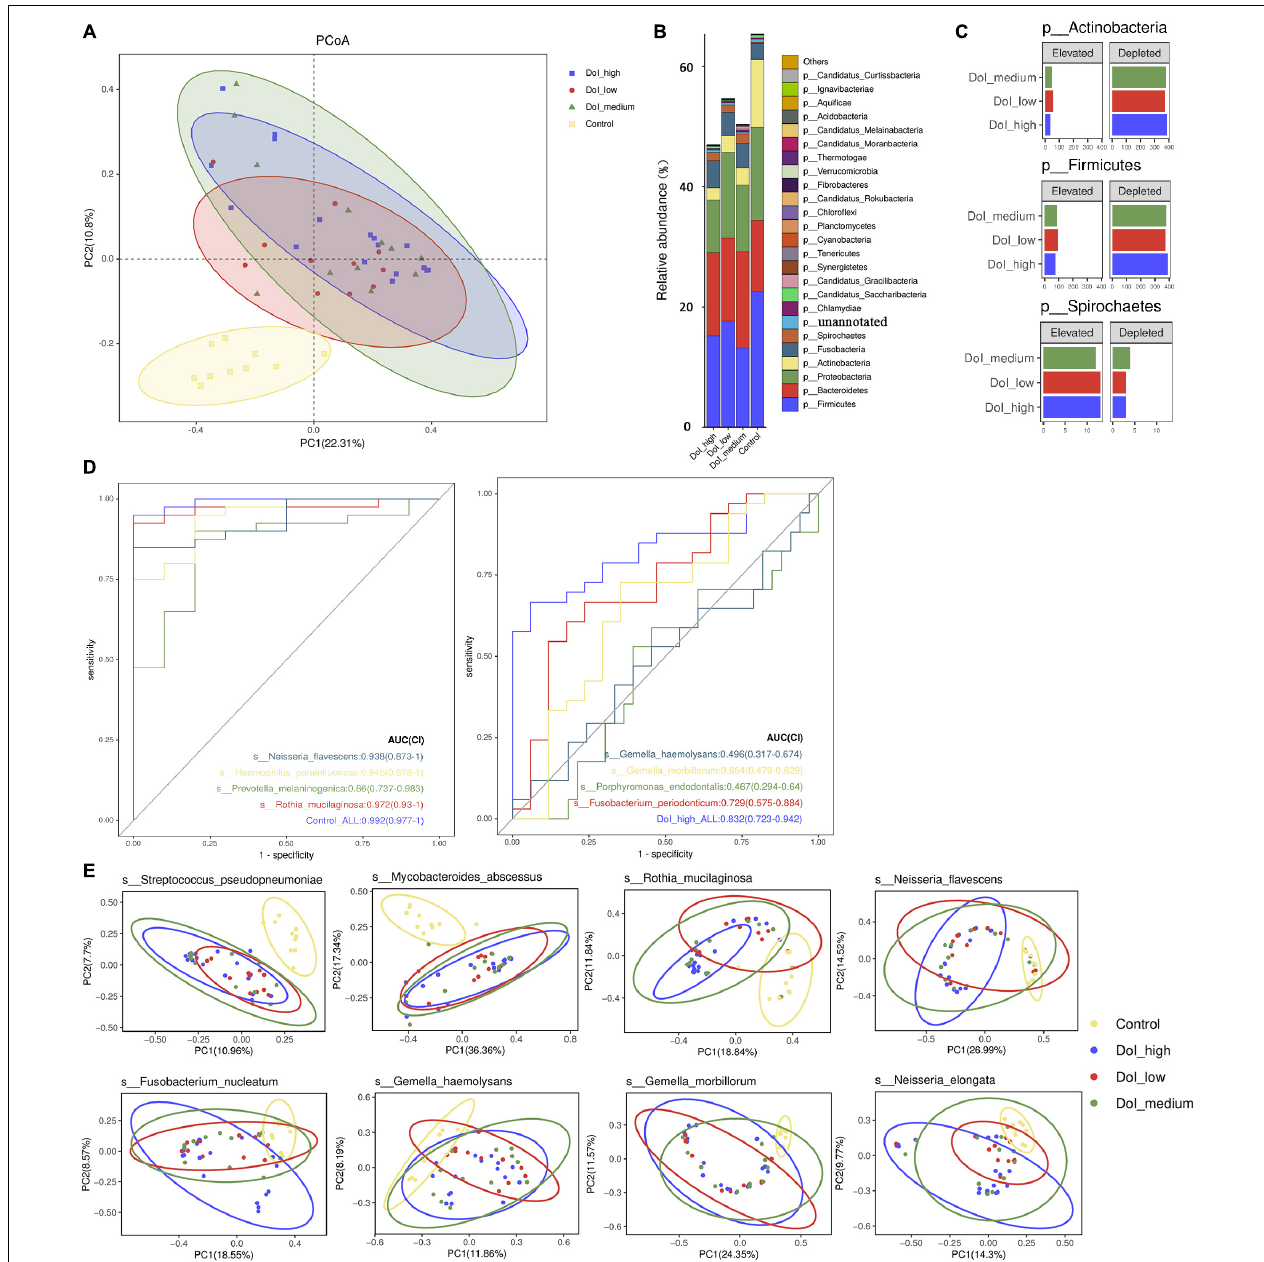
FIGURE 2 | Microbial diversity between the four groups. (A) PCoA was done on Bray-Curtis distances displaying β -diversity of the microbiome between the three DOI groups and the control. (B) Among the four groups, the main phylum changed obviously. Because the results of metagenomics included bacteria, fungi, and archaea, the total abundance of bacteria was less than 100%. (C) Phylum distribution of the number of species that were either elevated or depleted in each of the three stages compared with the healthy controls. (D) The ROC curve shows the significance of bacteria in predicting the grouping of the control and DOI-high groups. (E) The PCoA diagrams were done on the Bray-Curtis matrix based on the genes of annotated species which differed significantly between the four groups. The mapping method was to pick out the genes of the corresponding species, and then the vegdist function (method = Bray) in vegan package (version 2.5.5) was used to calculate the distance based on the abundance of the genes. The pcoa function in ape package (version 5.3) was used for calculation, and then the ggplot function (version 3.3.5) of the ggplot2 package was used for PCoA